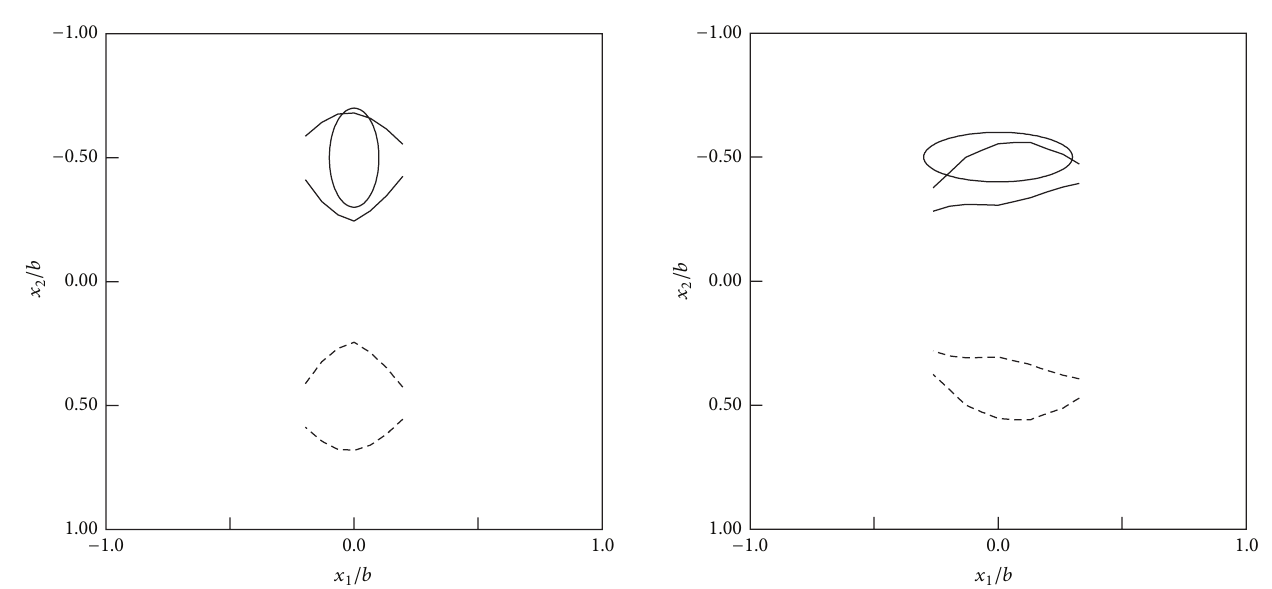
Figure 8: Reconstructed cavity with 𝑅 1 = 0.1𝑏 , 𝑅 2 = 0.2𝑏 , and ̃𝑥 2 = −0.5𝑏 .